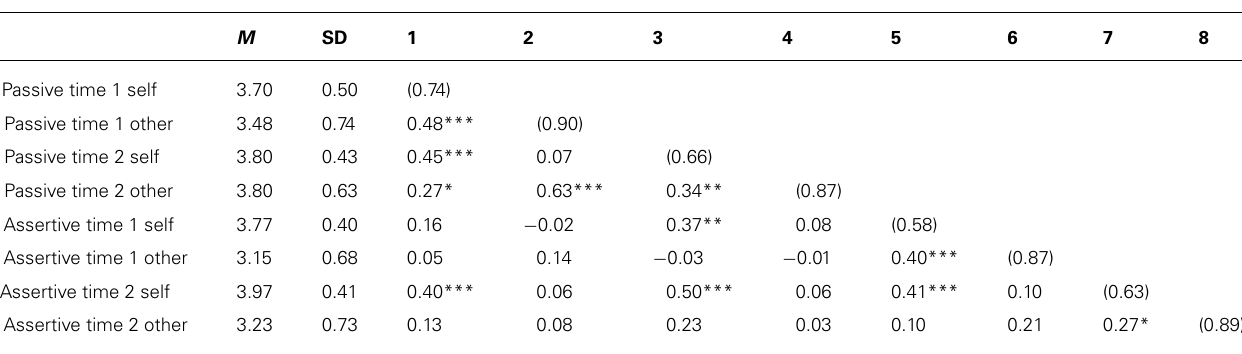
Table 1 | Mean values, standard deviations, correlations, and internal scale reliability for NMSPI. M